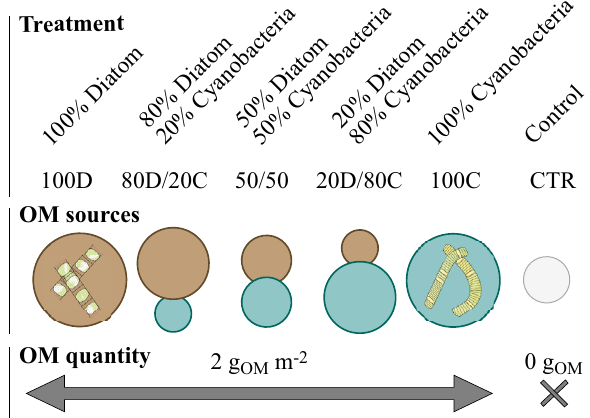
Figure 6. Experimental treatments. Organic matter (OM) quality varied in a gradient from 100% diatoms ( Skeletonema marinoi ) to 100% cyanobacteria ( Nodularia spumigena ), while OM quantity was standardized to 2 g OM m −2 , as estimated from loss-on ignition. The control treatment (CTR) received no OM